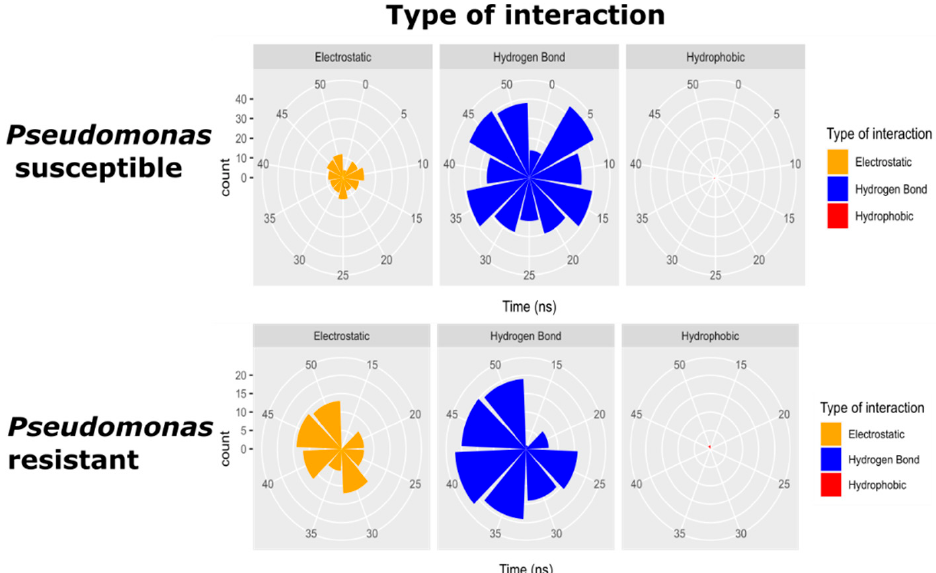
Figure 3. Type of intermolecular interactions between Δ M2 peptide and Pseudomonas membrane models through 50 nanoseconds. Electrostatic interaction (yellow). Hydrogen bond interaction (blue) and hydrophobic interaction (red).